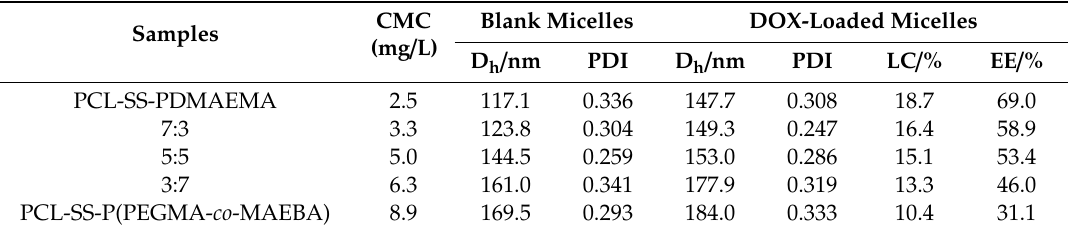
Table 2. Critical micellar concentration (CMC) values of the copolymer mixture and the D h , PDI, LC and EE of the mixed micelles.